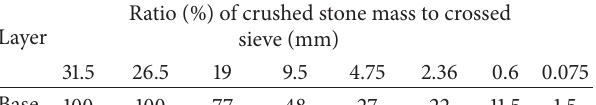
Table 1: Design gradation of semi-rigid base mixtures.